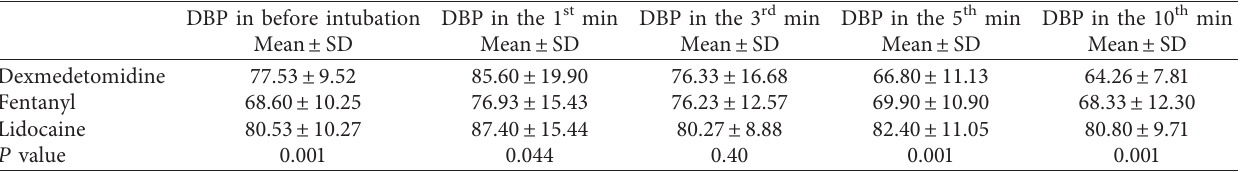
Table 4: Comparison of diastolic blood pressure in three groups in the 1st, 3rd, 5th, and 10th minutes after intubation with before intubation (meaningful level P < 0 . 05).